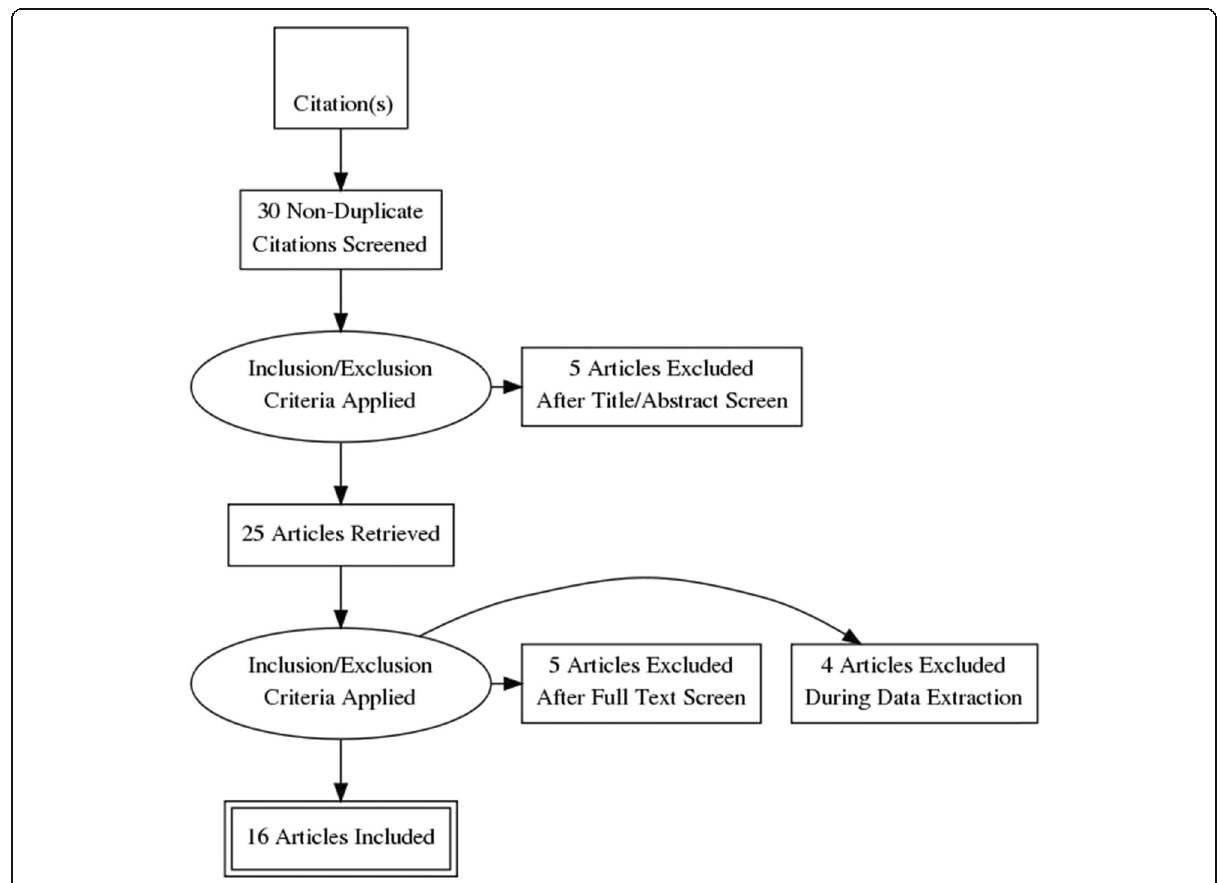
Fig. 1 PRISMA flowchart showing the steps in meta-analysis data